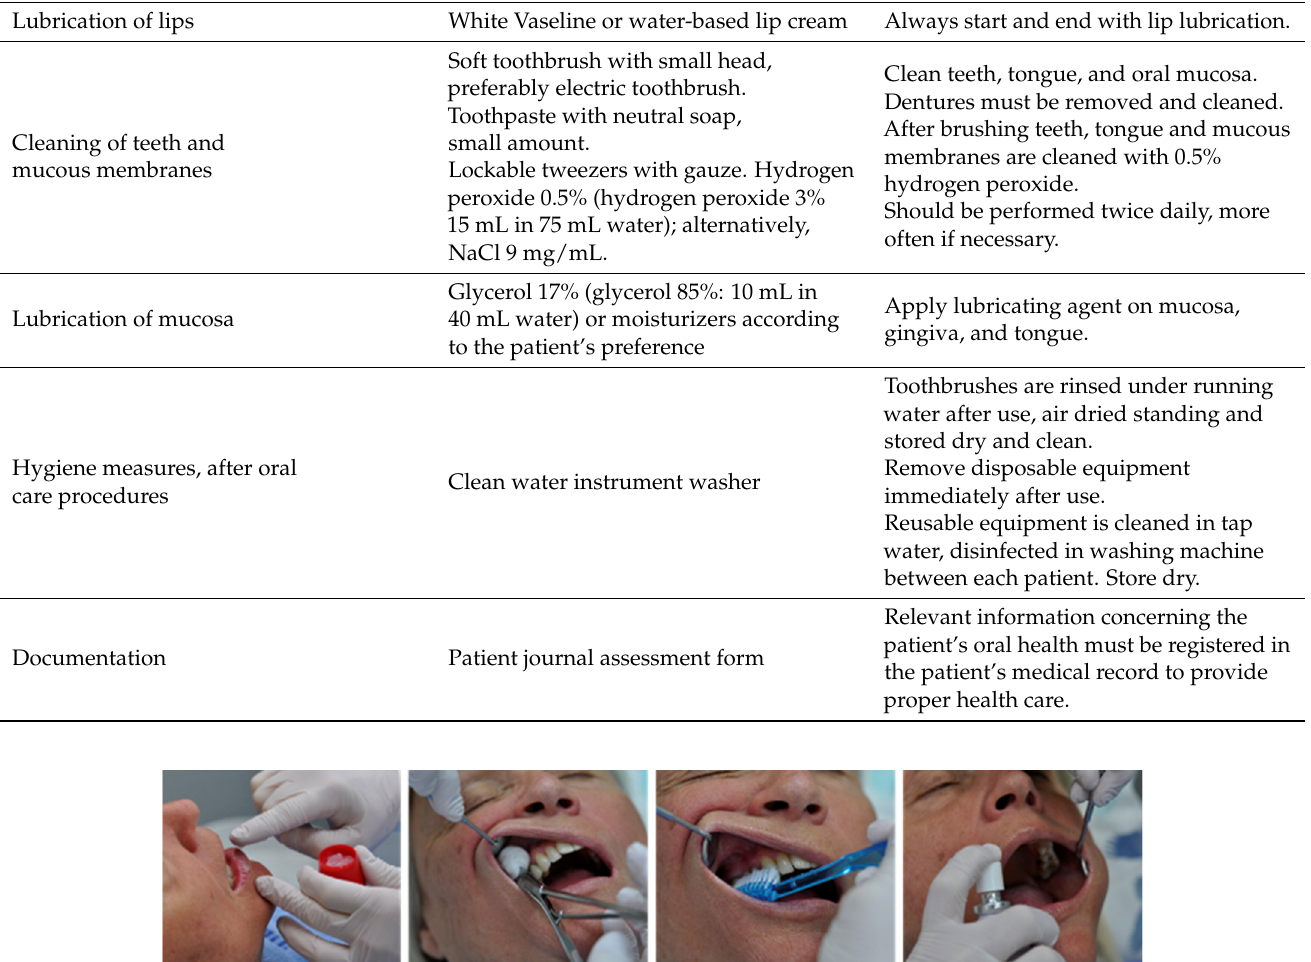
Figure 1. Illustration of oral care procedure: (1) lubrication of lips, (2) cleaning of mucous membranes, (3) cleaning of teeth and (4) lubrication of mucous membranes, here using a moisturizing spray.